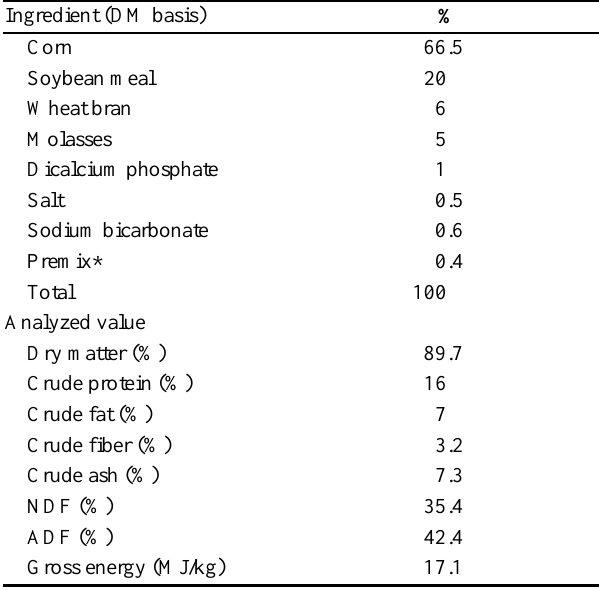
Table 1. The composition of experimental